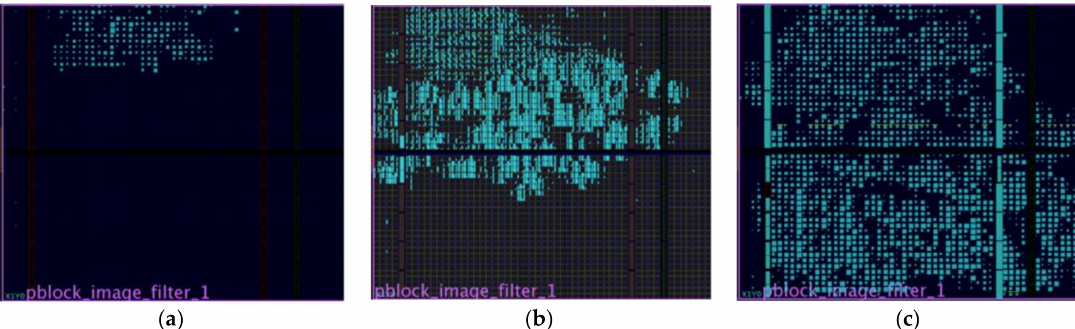
Figure 6. The desired reconfigurable module for the three investigated filters: ( a ) posterize, ( b ) Sobel operator, and ( c )